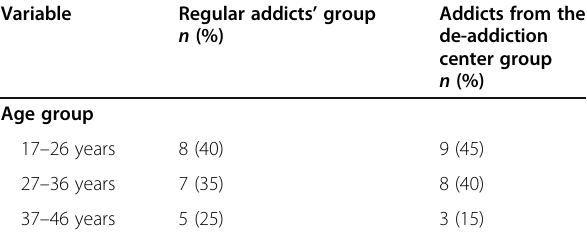
Table 3 6-MAM levels in regular addicts ’ group Sample no.